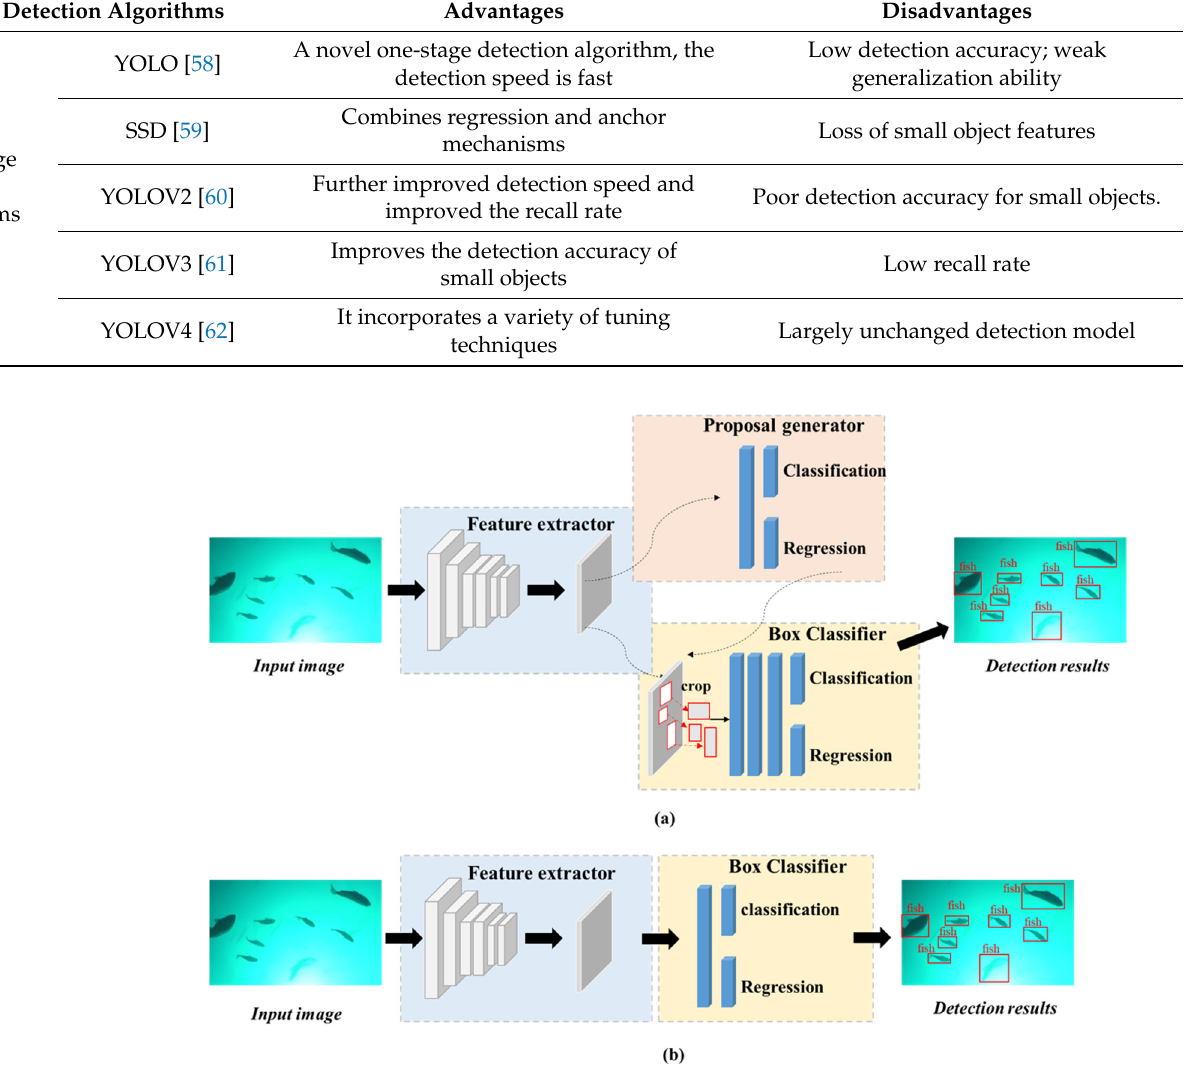
Figure 3. The basic fl ow chart of the two-stage ( a ) and one-stage ( b ) object detection